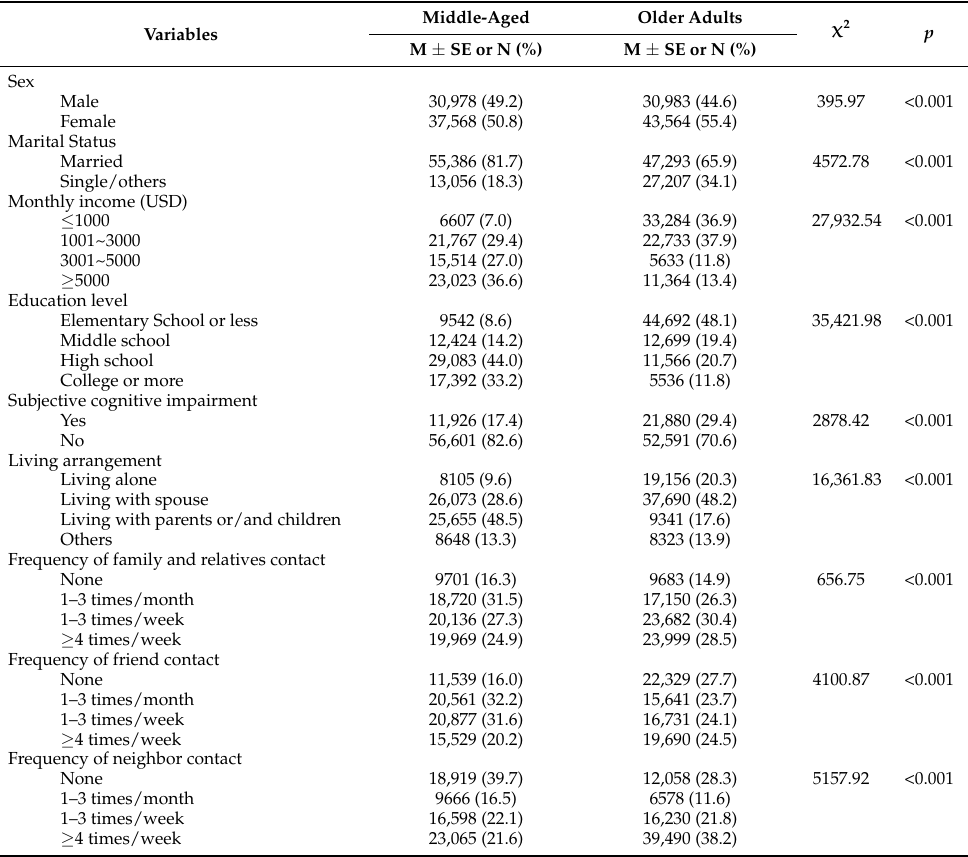
Table 1. Characteristics of the participants (N = 143,093).